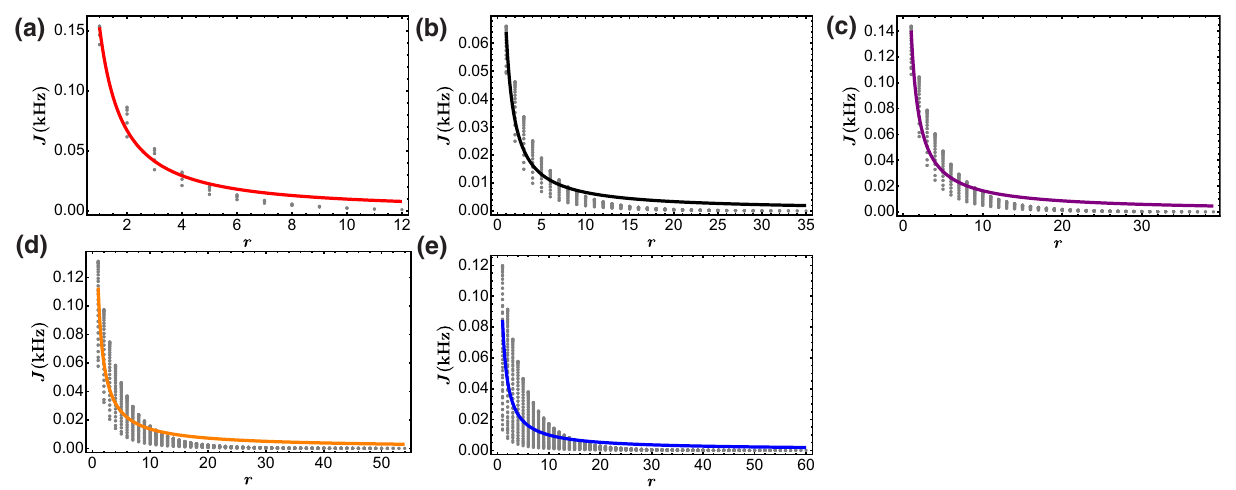
FIG. 6. Fit long-range Ising coupling. (a)–(e) Fitting results for N = 13, 36, 40, 55, 61 ions, respectively. Gray dots are the numerical results from the calibrated parameters. Solid lines are the J 0 / r α fitting results.